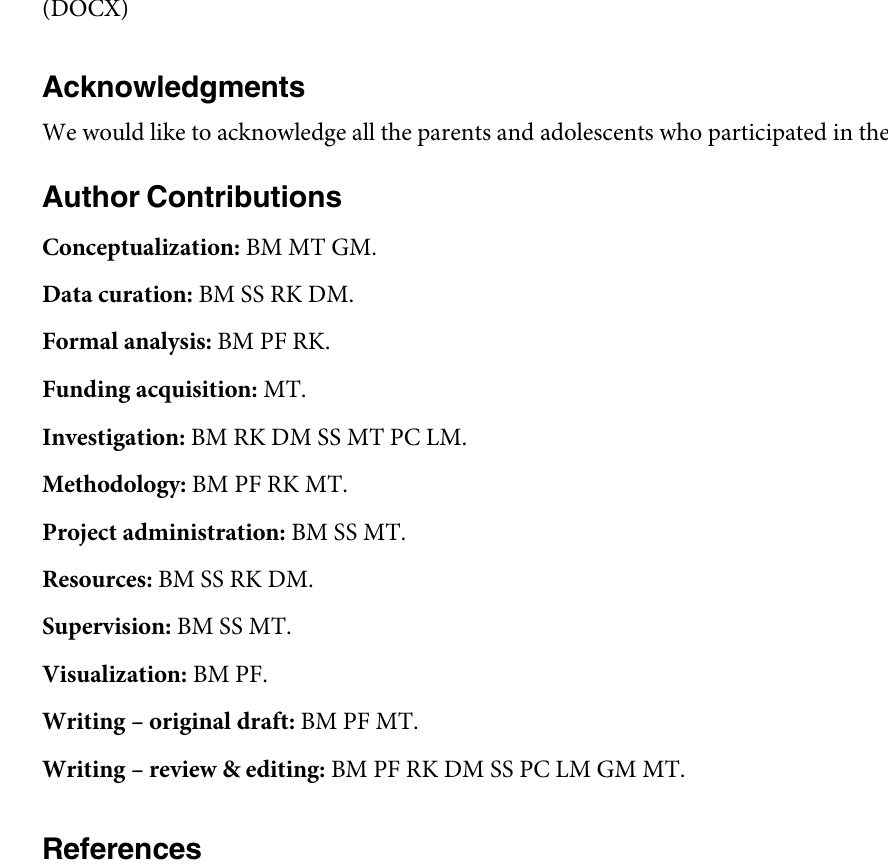
S3 Table. Values for attachment security and demographic variables in the sample of 220 adolescents included in the study compared to the rest of the original sample of 449 who were lost to follow-up (91), had died (24), or were followed up at adolescence but did not have both attachment and 5HTTLPR genotype data (114), making a total of 229 who were not included in this study. Statistical comparisons are given in Table 2. S4 Table. Comparison between the intervention and control groups for attachment secu- rity, genotype, and demographic variables. No significant differences were found. (DOCX) S1 Text. Details of the multiple imputation analyses testing for the effect of missing data on the main